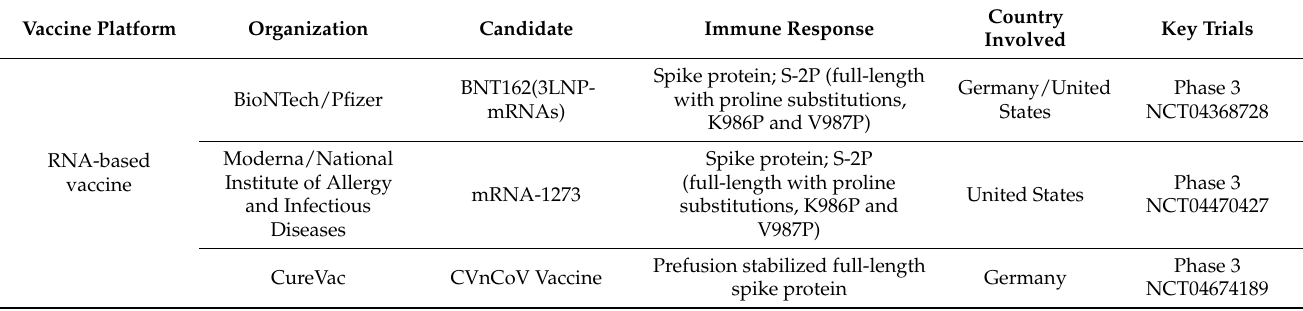
Table 1. Advanced vaccine